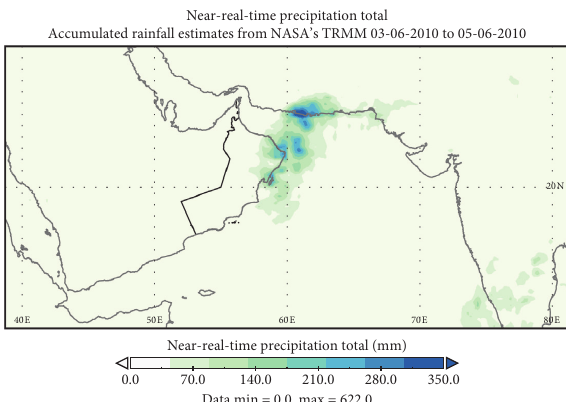
Figure 14: Near real-time daily accumulated rainfall estimates from NASA’s TRMM satellite for three days (3–5 June 2010).